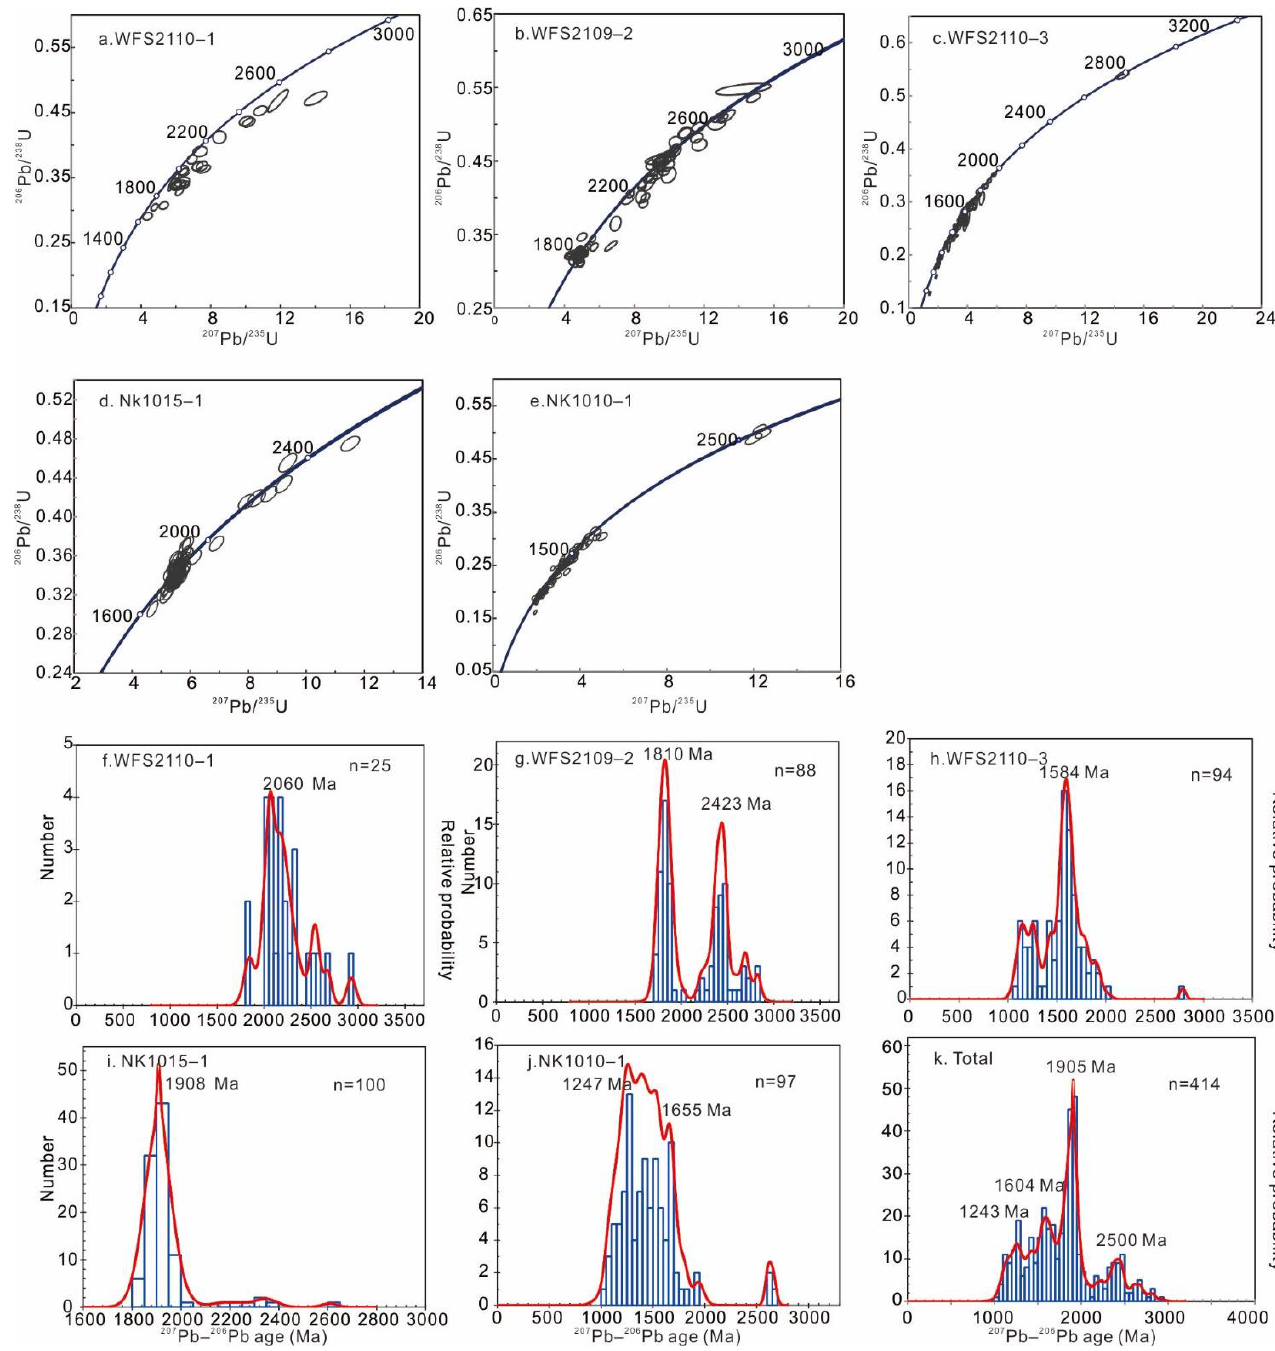
Figure 6. U–Pb concordia and relative probability plots of detrital zircons of the samples from the target successions. Ages are in Ma and ellipses show 1 σ